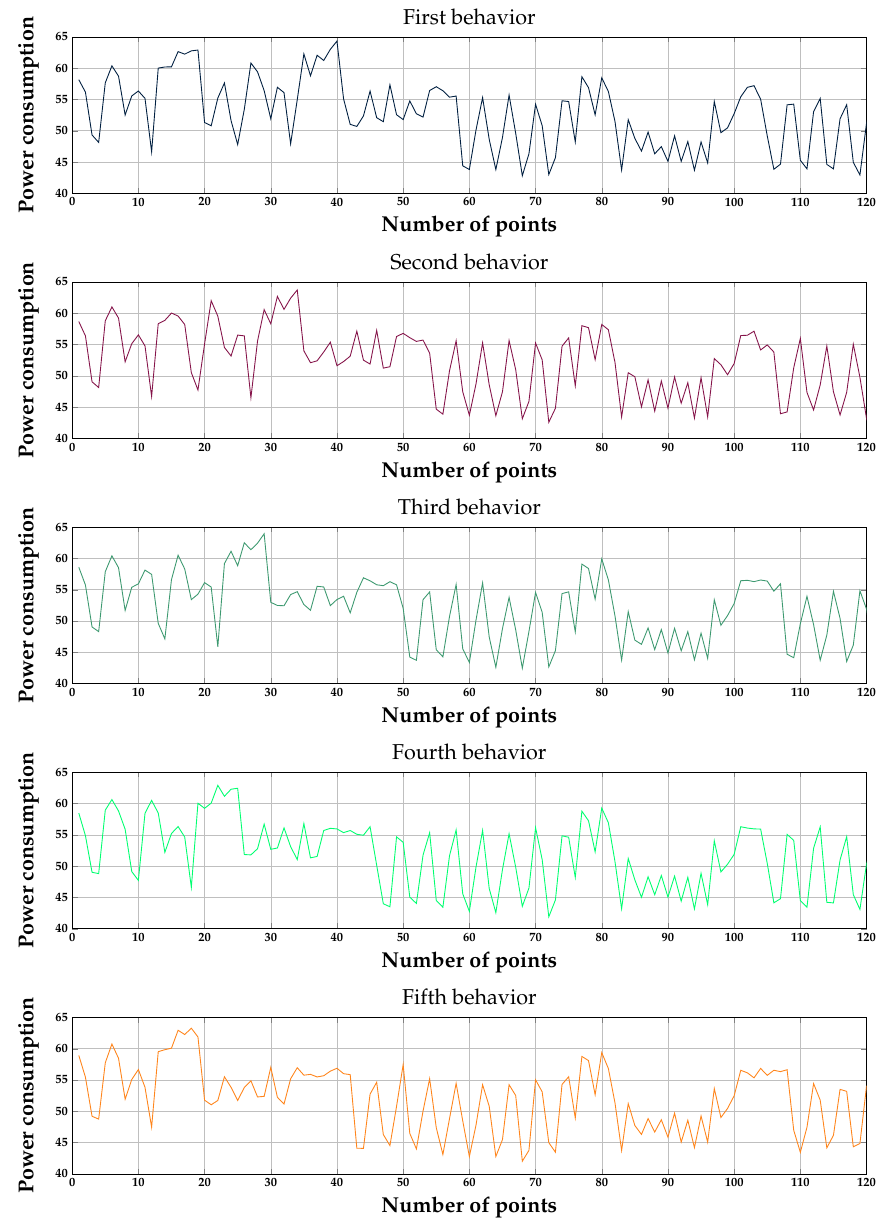
Figure 7. Five behaviors when operating DEA